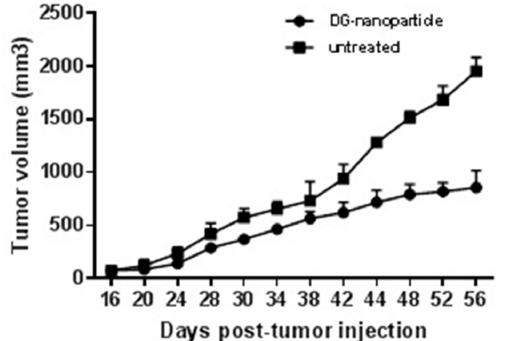
Fig. 6. 4T1 Xenograft tumor cells growth (average volume of the tumor (mm3) ± standard